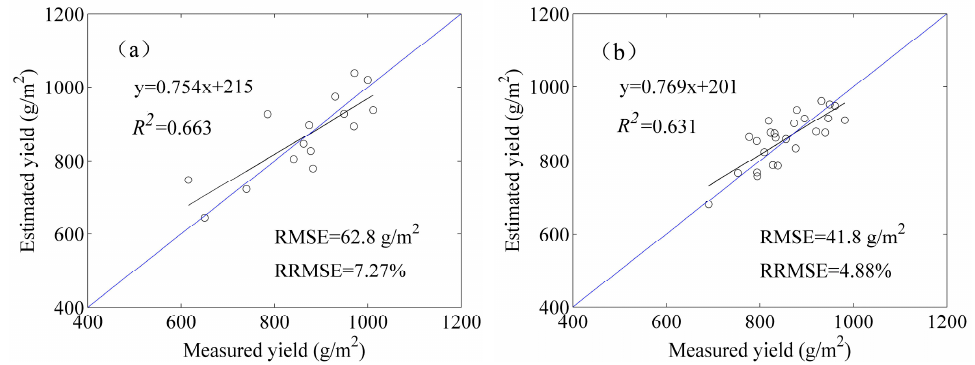
Figure 10. Comparisons between the measured and estimated winter wheat yields: ( a ) Site 1; and ( b ) Site 2.